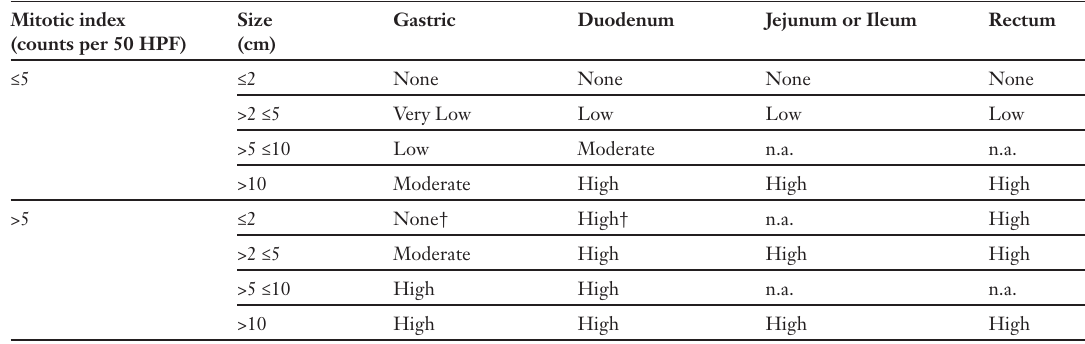
Risk stratification of primary GIST accord- ing to tumour size and mitotic activity, a consensus approach 2002 [22] (HPF, high power field corre- sponding to 5 mm 2 ).